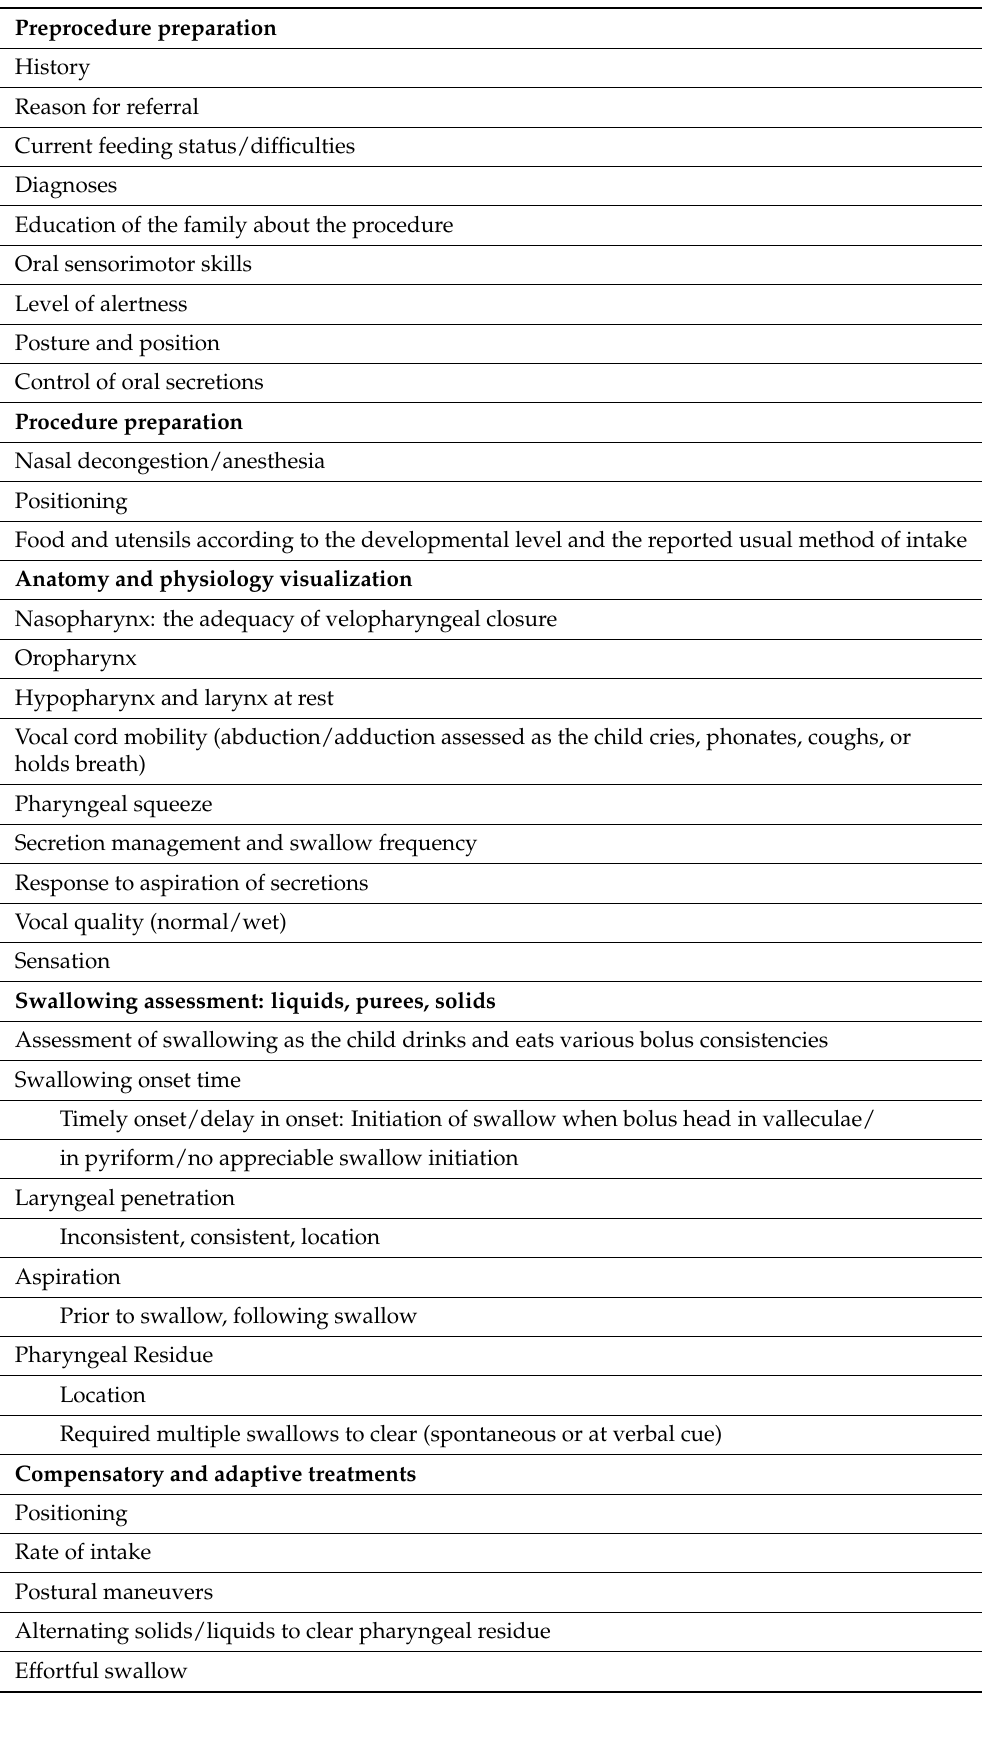
Table 1. A pediatric FEES